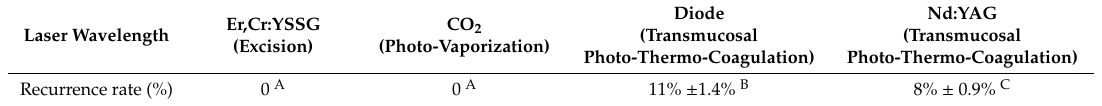
Table 5. Recurrence rate of di ff erent surgical procedures.